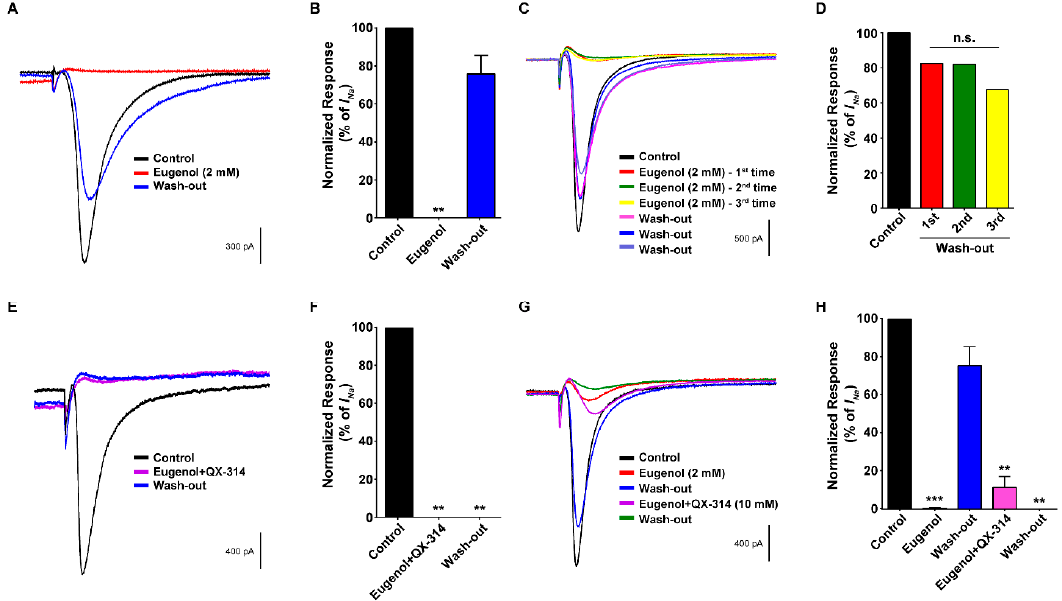
Figure 4. E ff ect of co-administration of QX-314 and eugenol on voltage-gated sodium channel currents in small-sized TG neurons. ( A ) Eugenol alone reduced voltage-gated sodium channel (VGSC) currents, which recovered after wash-out. VGSC currents were measured during 80 ms voltage steps delivered every 3 s from a holding potential of − 60 mV to a test potential of 0 mV. ( B ) The proportion of VGSC current inhibition as a result of eugenol (2 mM, n = 15). ( C ) The interval (wash-out) time between repeated eugenol treatments (3 times) is at least 5 min. Eugenol (2 mM) inhibited VGSC currents repeatedly. After wash-out, the currents recovered to at least 70% of the control level. ( D ) The rate of VGSC current recovery after wash-out in TG neurons. The VGSC currents recovered to at least 70% of the control trace. ( E ) Representative traces of VGSC currents after the co-administration of eugenol and QX-314. QX-314 (10 mM) and eugenol (2 mM) inhibited VGSC currents, which did not recover for at least 40 min after wash-out. ( F ) The proportion of VGSC currents inhibited by eugenol and QX-314 ( n = 8). ( G ) Eugenol alone and in combination with QX-314 suppressed VGSC currents. Trace showing the e ff ects of eugenol (2 mM; red trace), the combination of eugenol and QX-314 (pink trace), and the control (shown as a black trace) on VGSCs. ( H ) The proportion of VGSC currents inhibited by eugenol and its combination with QX-314. ** p < 0.01 versus control, *** p < 0.001 versus control and n.s: not significant.